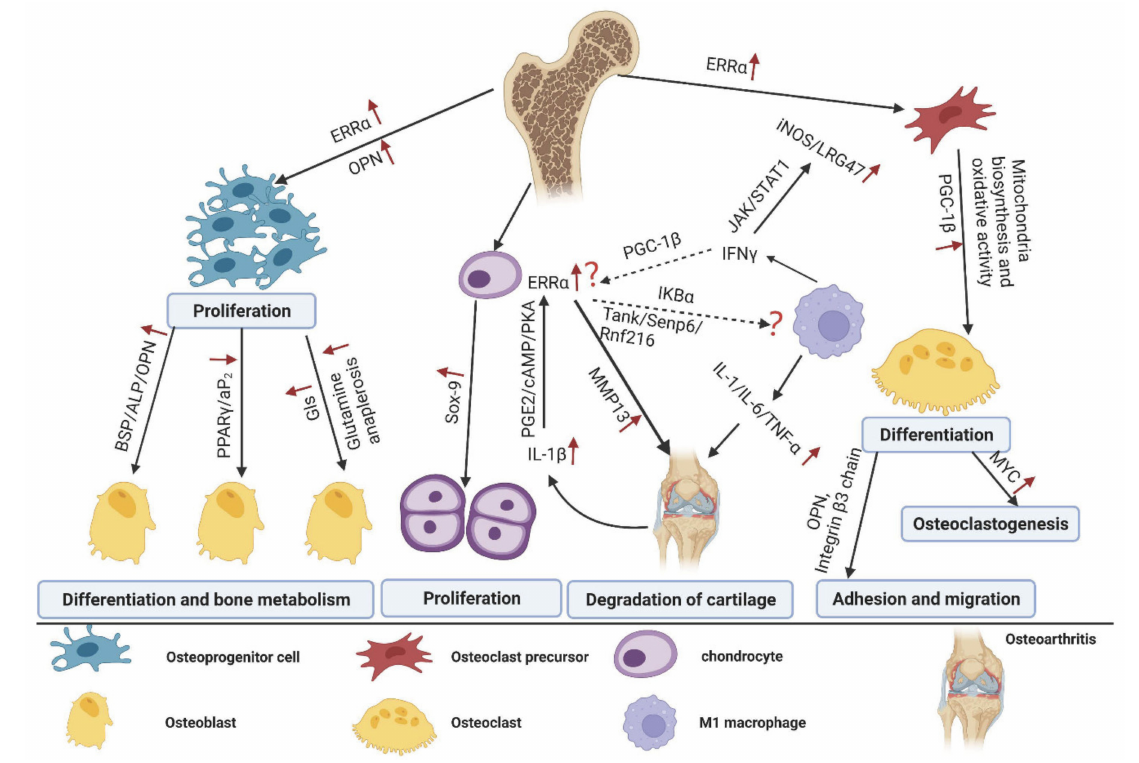
Figure 2. The regulatory mechanism of ERR α in the function of bone associated cells and bone metabolism. On the one hand, ERR α impacts osteoblast development and metabolism by upreg- ulating BSP/ALP/OPN, Gls-mediated glutamine anaplerosis and inhibiting PPAR γ /aP2, which ultimately results in the differentiation and proliferation of osteoblasts. On the other hand, ERR α interacts with PGC-1 β to promote osteoclast formation, adhesion, and migration through regulating the expression of OPN and integrin β 3, mitochondrial metabolism and oxidative processes in a synergistic manner. In the cartilage, upregulation of SOX-9 induced by ERR α promotes chondrocyte proliferation, while ERR α expression could be activated through the PGE2/cAMP/PKA signaling pathway in response to IL-1 β stimulation, the receptor modulated the synthesis of MMP-13 and caused osteoarthritis. Elevated iNOS or cytokines including IFN- γ and TNF- γ could activate M1 macrophages to release IL-1 β , this positive feedback loop might lead to cartilage erosion and os- teoarthritis. However, the interactive modulation between ERR α and macrophages in the cartilages is still